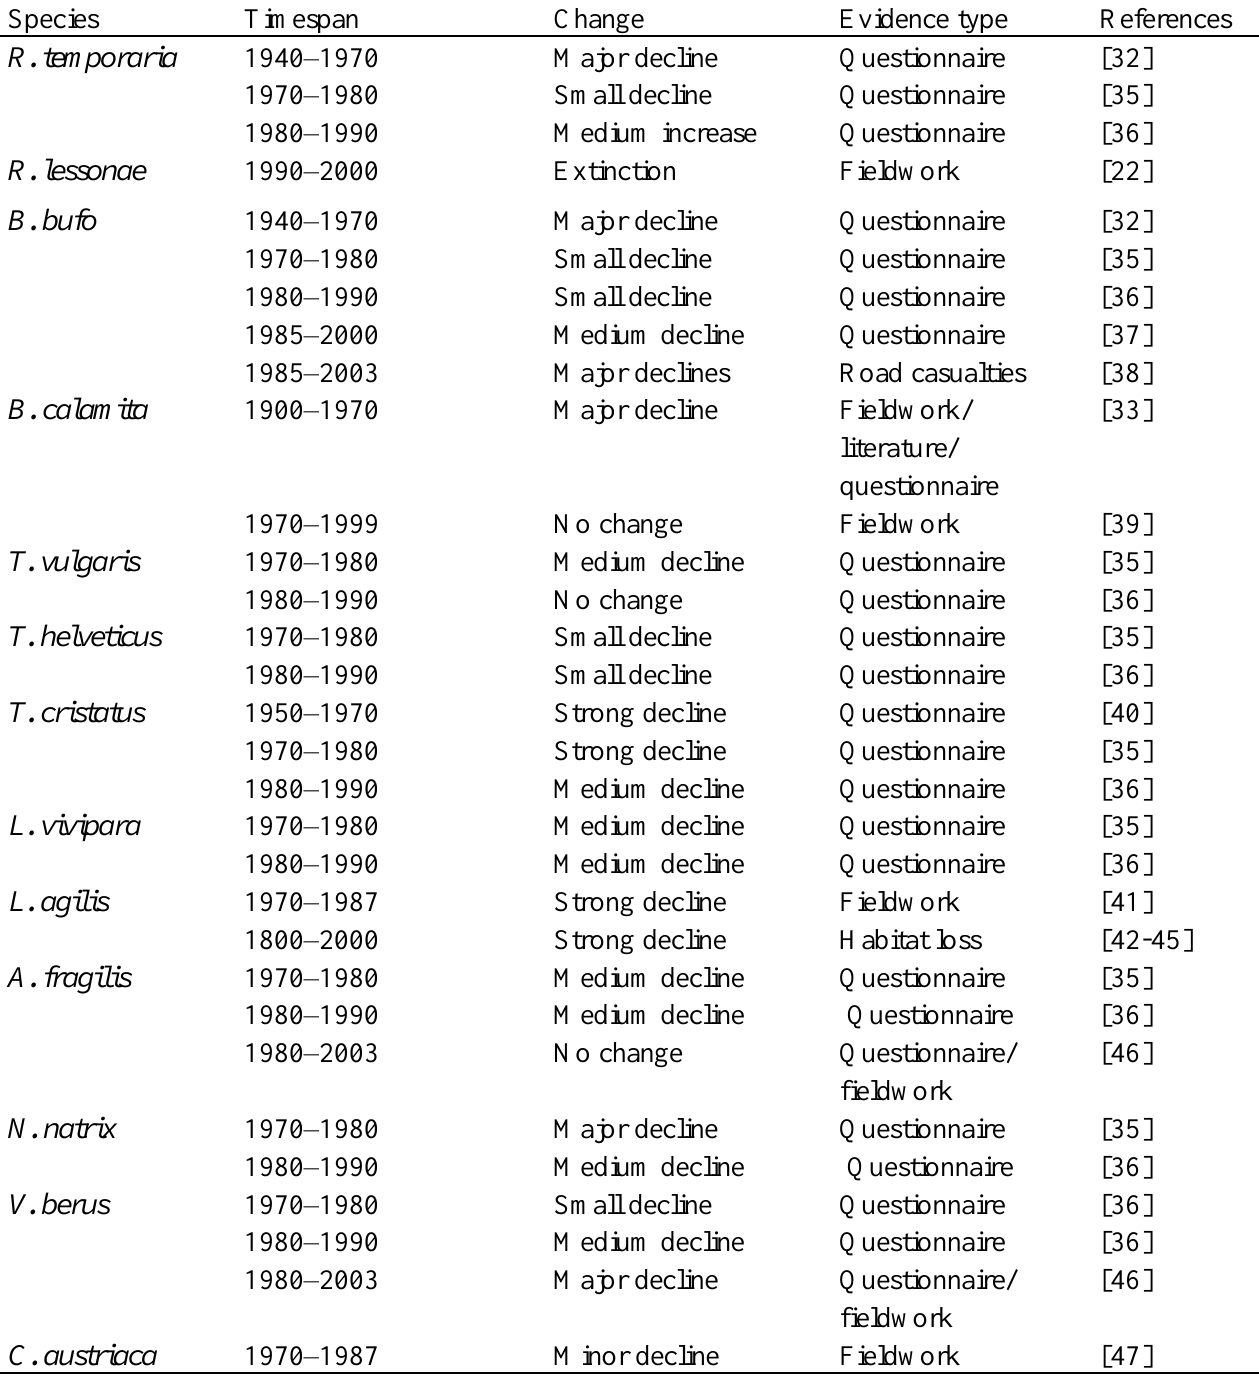
Table 5. Evidence of amphibian and reptile status changes in Britain. For indices based on questionnaires, values <0.05 = no significant change; 0.05–0.15 = small change; 0.15–0.3 = medium change; >0.3 = major